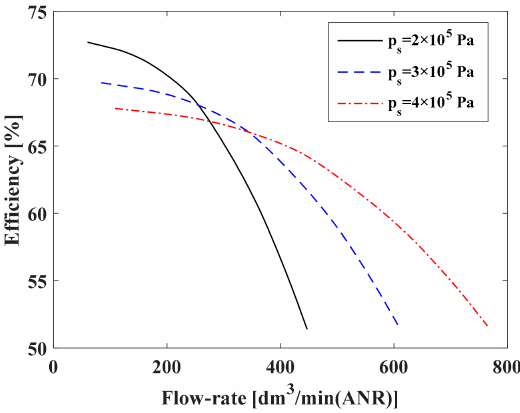
Figure 14. Energy efficiency of VBA-R.